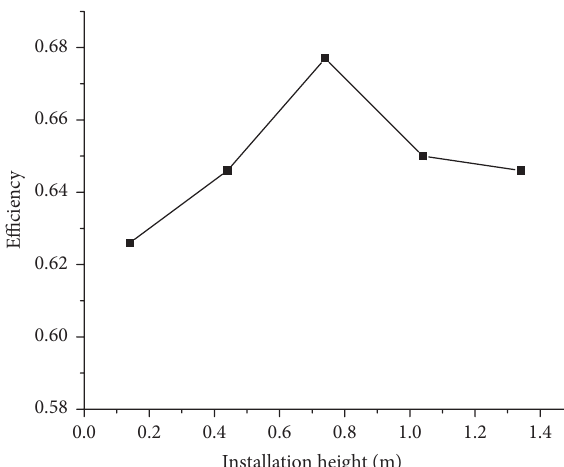
Figure 7: Effect of the height of the water tank on the efficiency of the solar